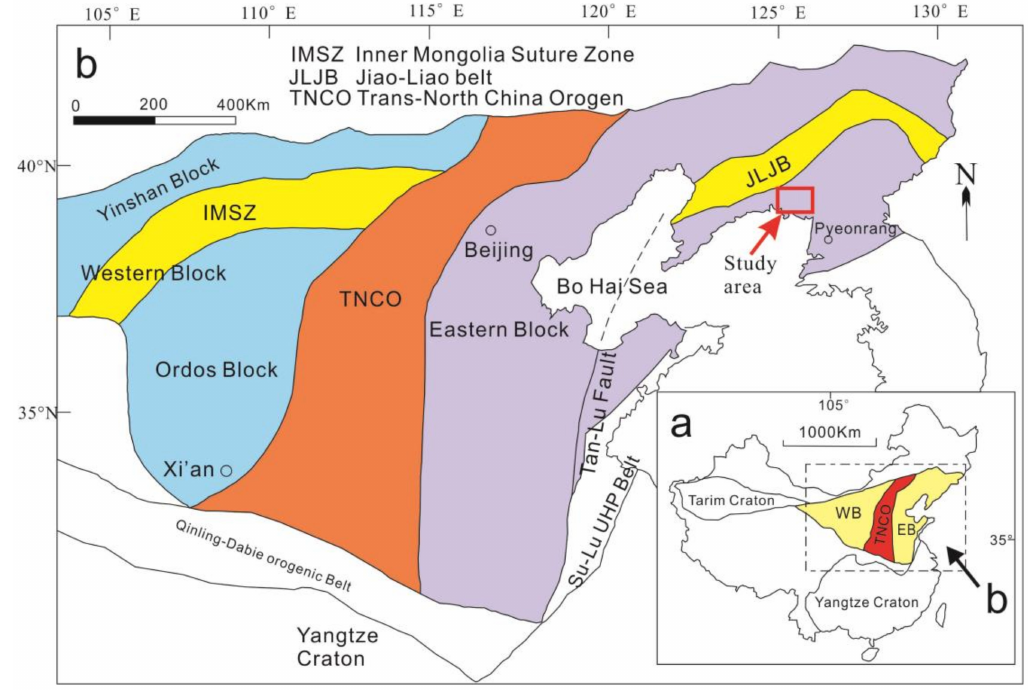
Figure 1. Major tectonic units of the North China Craton. (Modified after [26,31]). The Qingchengzi gold district is located in Liaoning Province, northeastern the NCC (Figure 1). This area is dominated by amphibolite and marble of the late Proterozoic Liaohe Group, including the Lieryu Formation; Gaojiayu Formation, Dashiqiao Formation and Gaixian Formation. The Liaohe Group formed in the Paleoproterozoic (2.05–1.92 Ga) based on zircon U–Pb dating evidence [35]. The Liaohe Group consists of amphibolites, felsic gneiss, Bt-Pl gneiss, Sil-Grt gneiss and marble (Figure 2). The Cretaceous Xiaoling Formation, mainly containing rhyolite and andesite, is distributed in the southern Qingchengzi gold